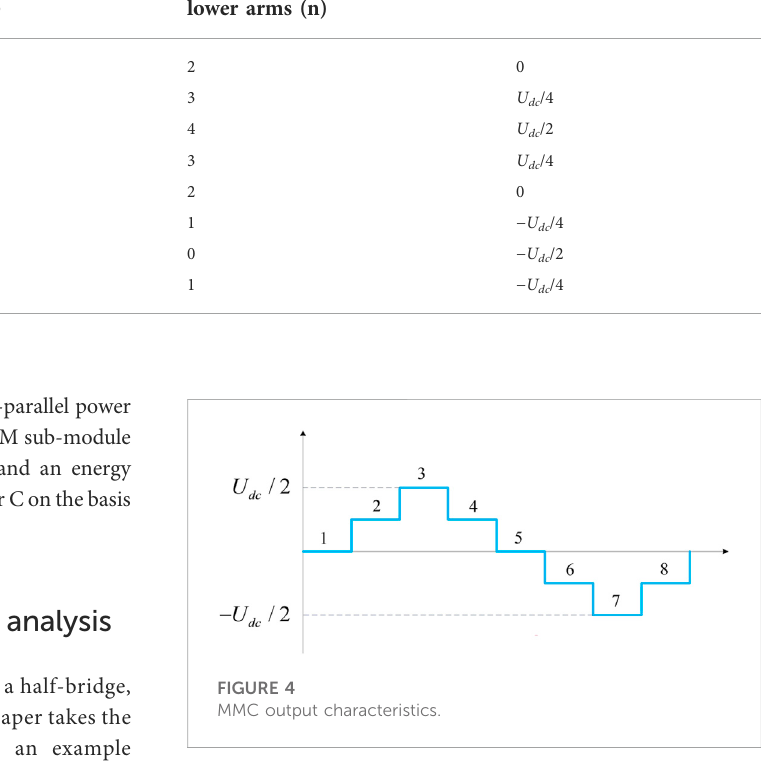
TABLE 2 Relationship between working state and the number of input sub-modules. Running state